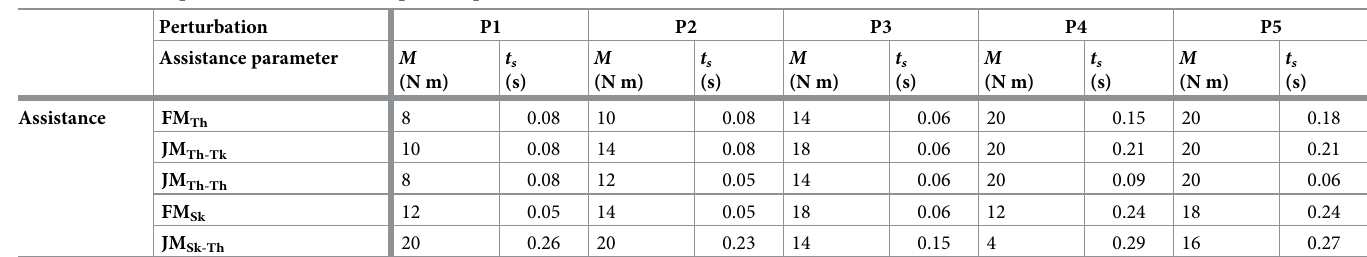
Table 3. Assistance parameters of best case response to perturbations P1–5. Perturbation Assistance